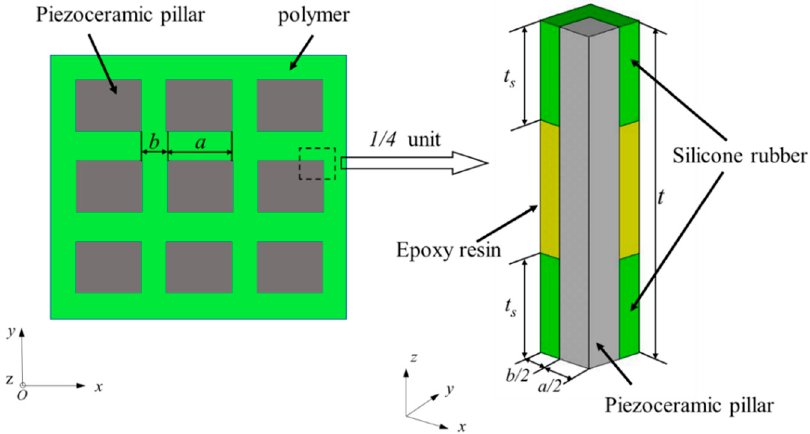
Table 2. Parameters of polymer.